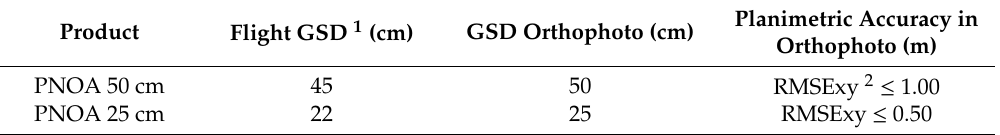
Table 1. Main characteristics of data derived from the National Plan for Aerial